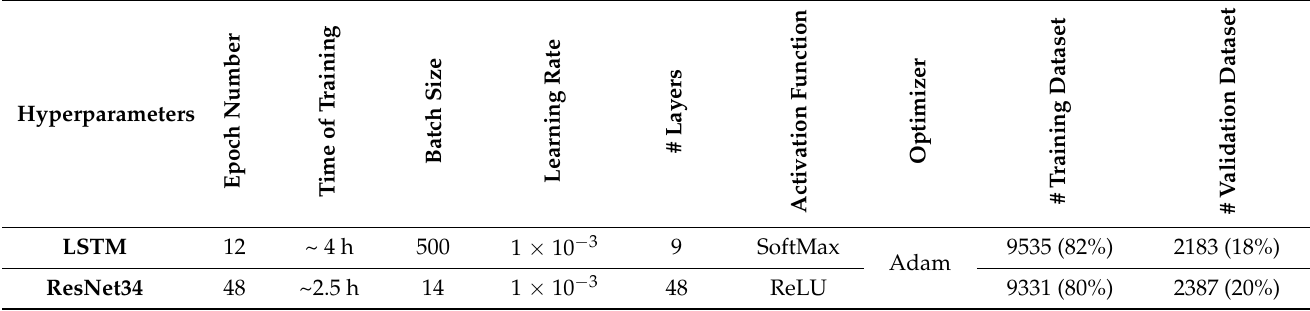
Table 4. Hyperparameters are used in the training of LSTM and ResNet34 neural